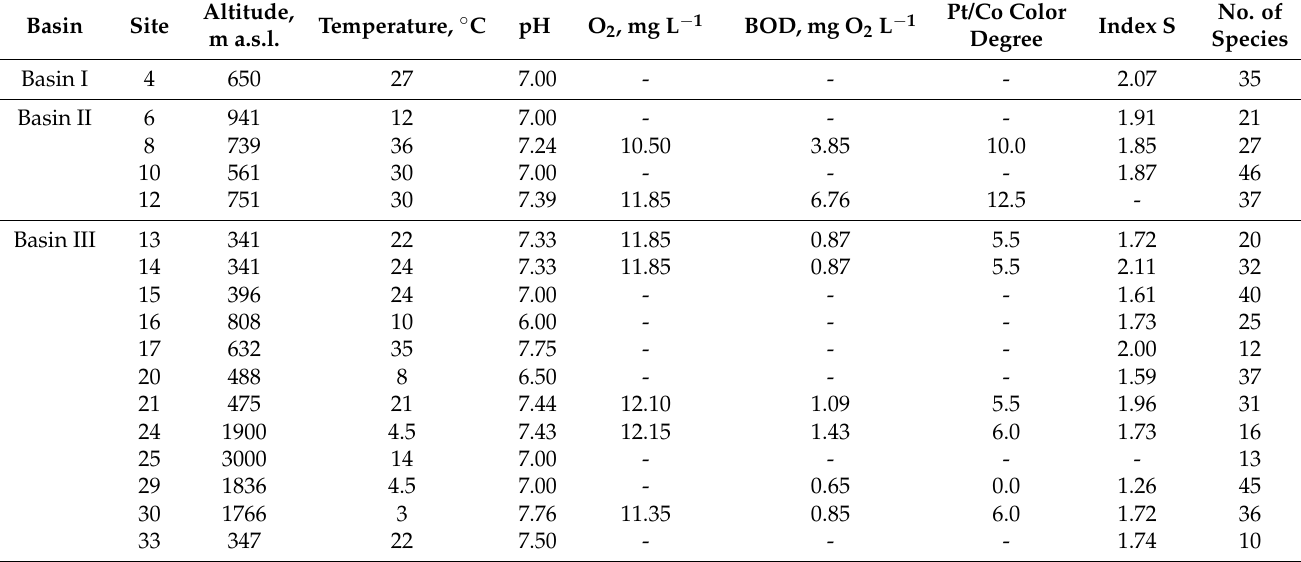
Table 3. Average data for environmental variables of water in studied sites of south and southeast Kazakhstan, 2019–2022. Data for dissolved oxygen, BOD, and odor were taken from the references